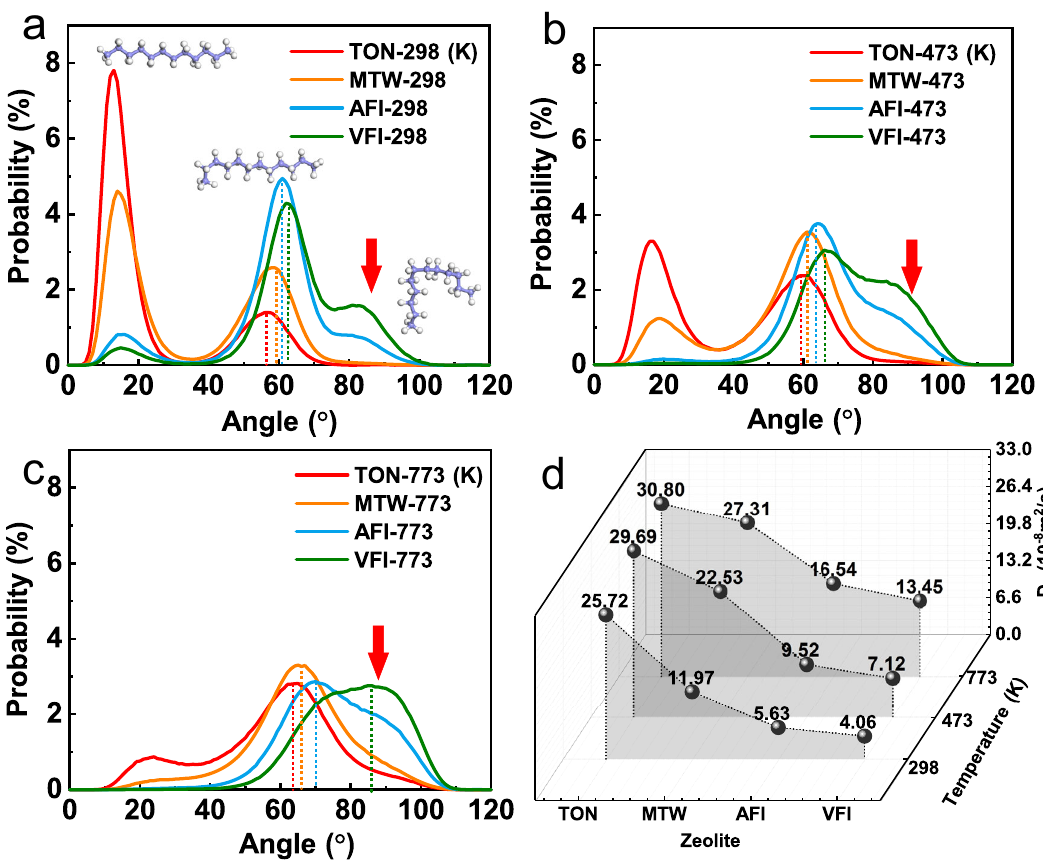
Fig. 4 | The deformation angle and diffusion coef fi cients in the zeolites. The deformation angle of C12 in the 1D channel of the zeolite at a 298K, b 473K, and